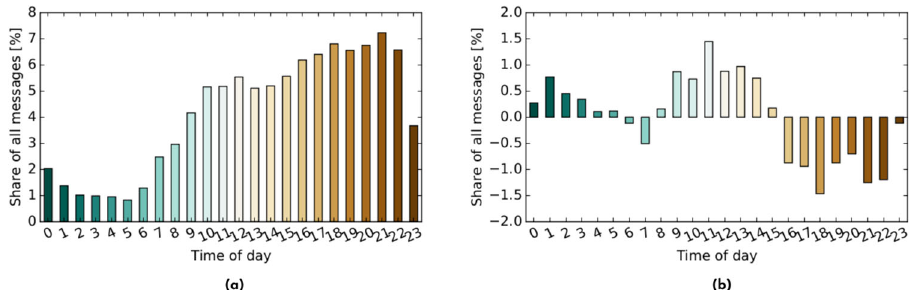
Fig. 5 Share of messages per time of day for the 2-month period 2019 and its changes in the lockdown period 2020. In ( a ), the bars show the percentage of messages per time of day in the 2-month period 2019. In contrast, ( b ) illustrates the changes of the communication behavior from the pre- pandemic period to the lockdown period 2020. Here, each bar shows the differences between the number of sent messages per time of day of both periods.